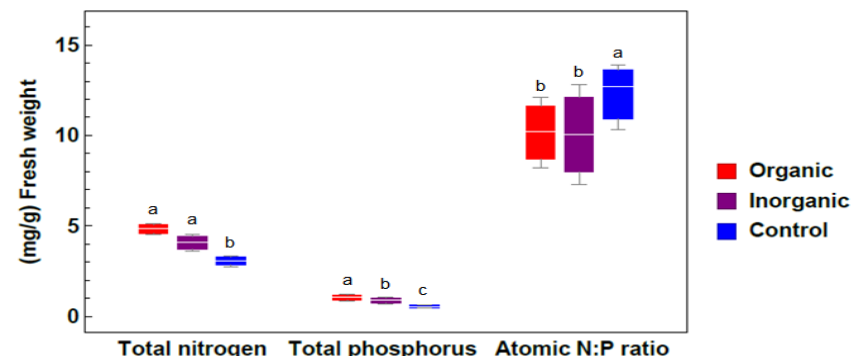
Figure 4. The variation of the total nitrogen (TN), total phosphorus (TP), and N: P ratio in tissues of Azolla sp. exposed to different treatments (means ± standard errors from three independent experiments under different treatments: organic, inorganic and control). Different lowercase letters indicate significant differences between different treatments at P ≤ 0.05 .